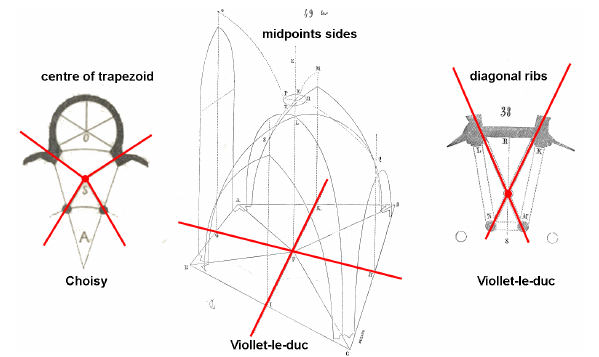
Figure 3 : trapezoidal vault tracing: geometric rules from sources